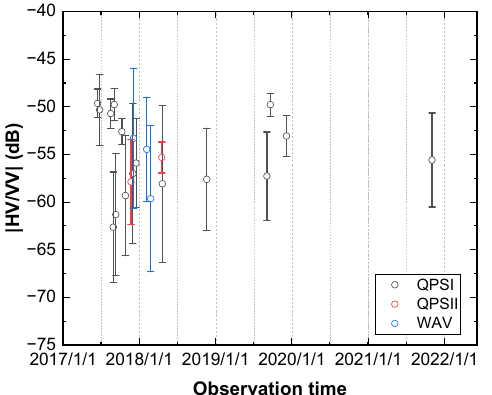
Figure 10. GaoFen-3’s crosstalk evaluation based on the modified Quegan method with Amazon forests datasets of QPSI, QPSII, and WAV modes from June 2017 to November 2021. Here, we present the mean and standard deviation (std) measurements of the HV/VV channel ratio in amplitude with the calculated polarimetric distortions from the forest samples.